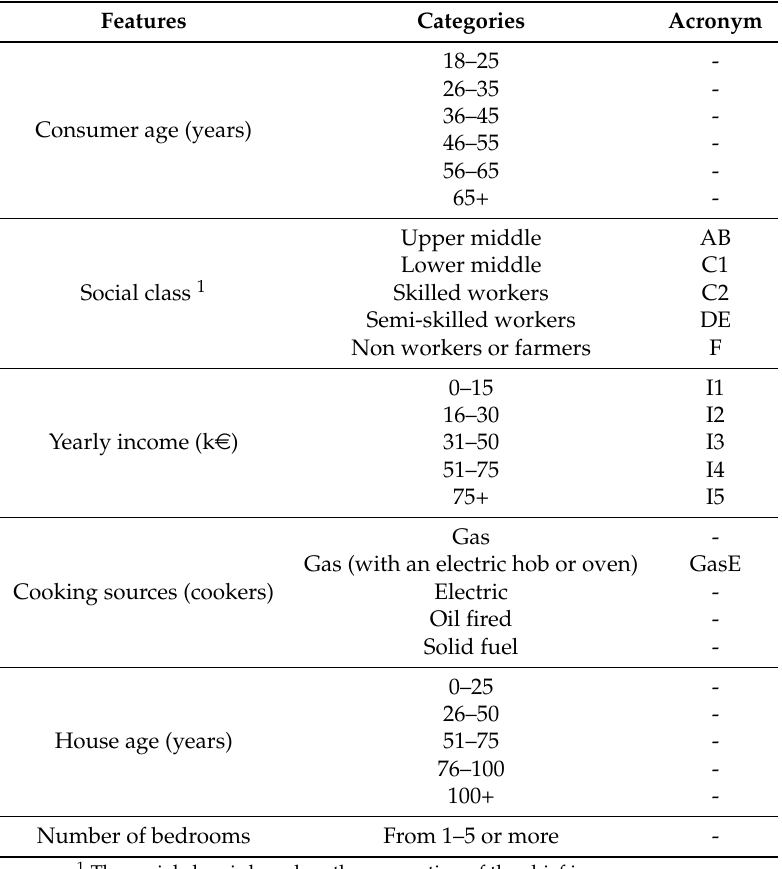
Table 3. Socio-economic and household key features and respective categories.